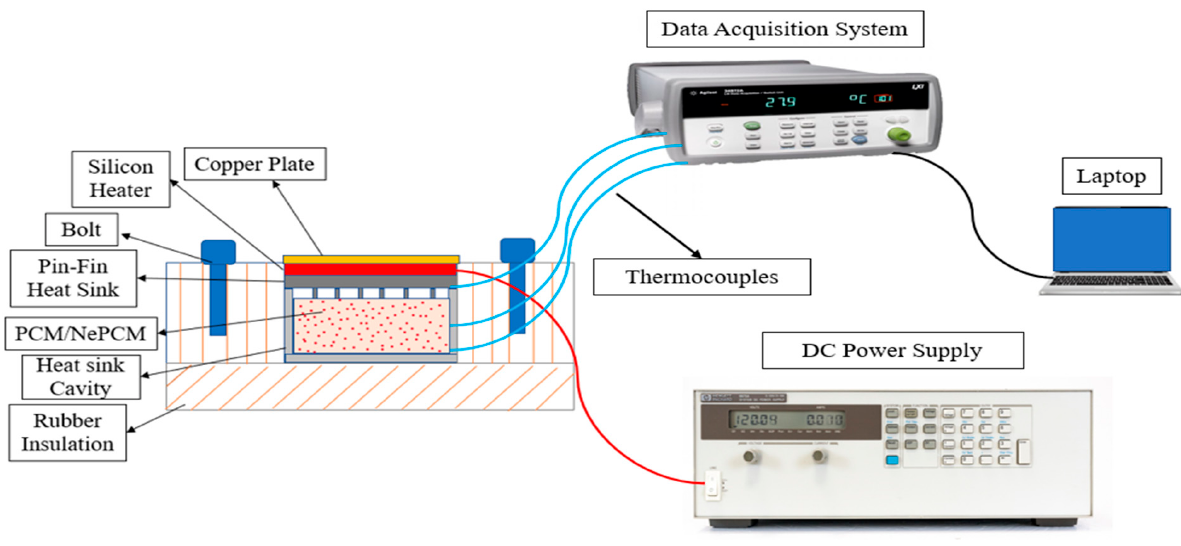
Figure 1. Schematic Diagram of Experimental Setup.